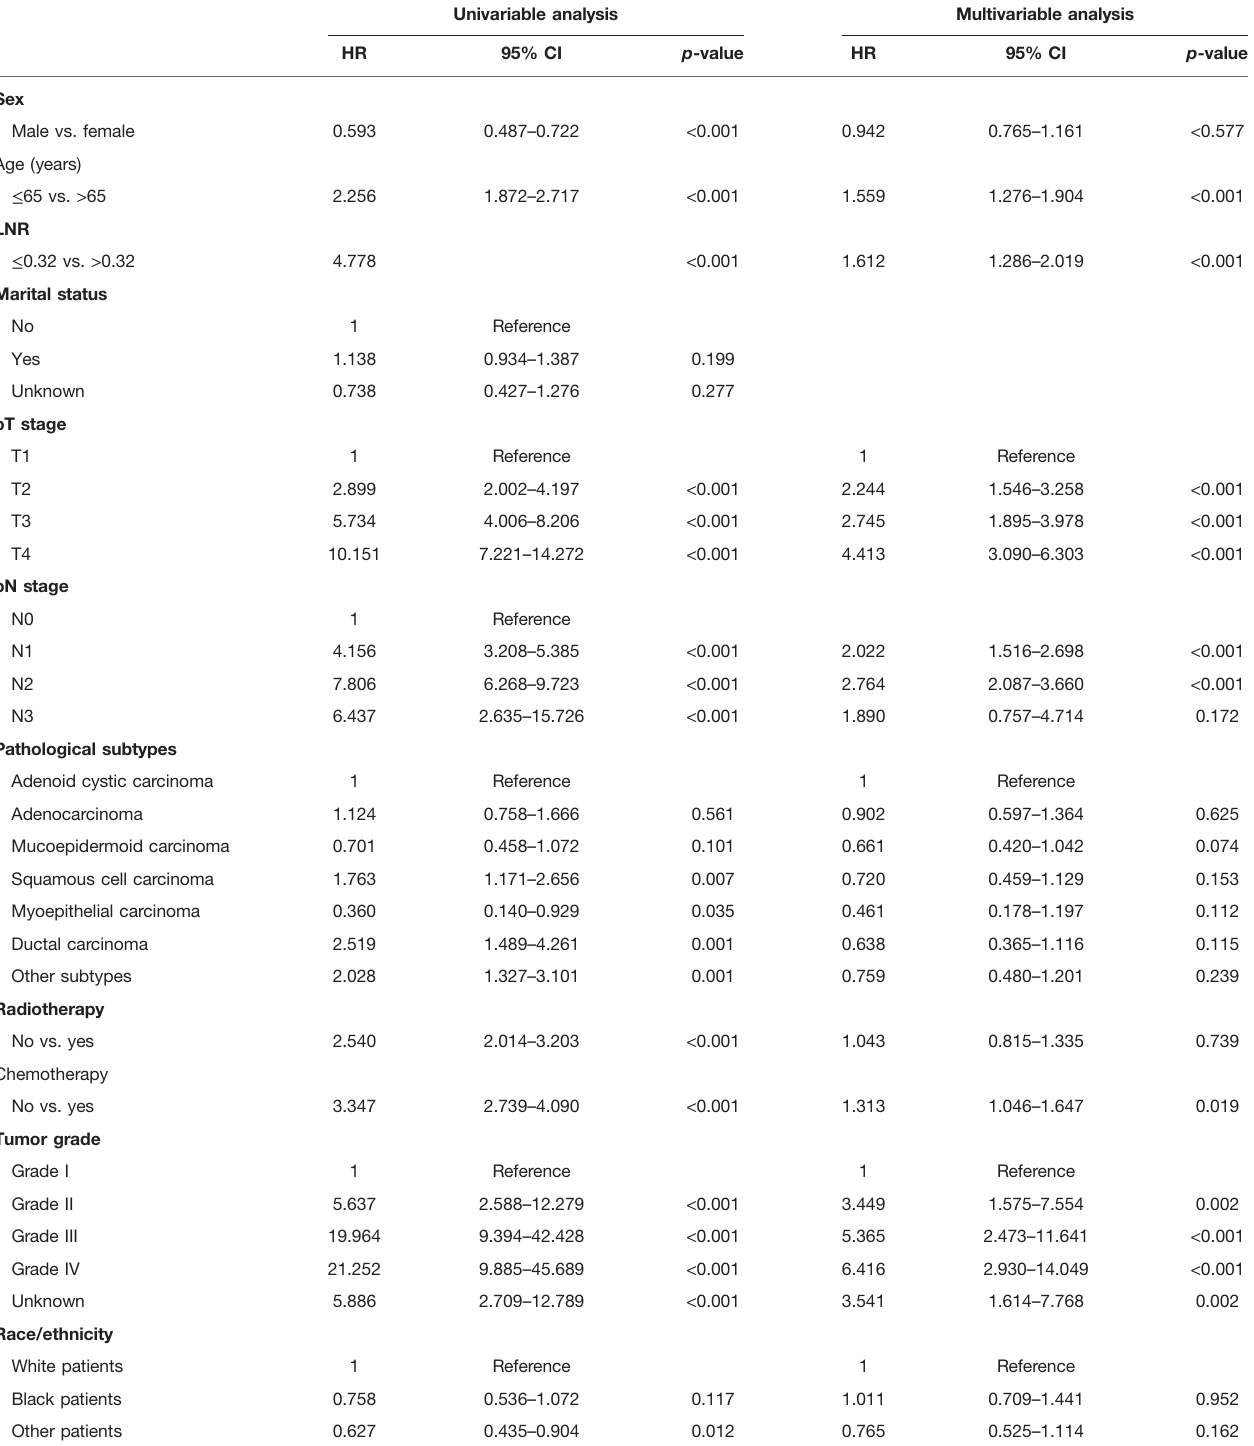
TABLE 3 | Univariable and multivariable Cox proportional hazard regression analyses for overall survival in parotid gland cancer patients with stage I – IV from Surveillance Epidemiology and End Results